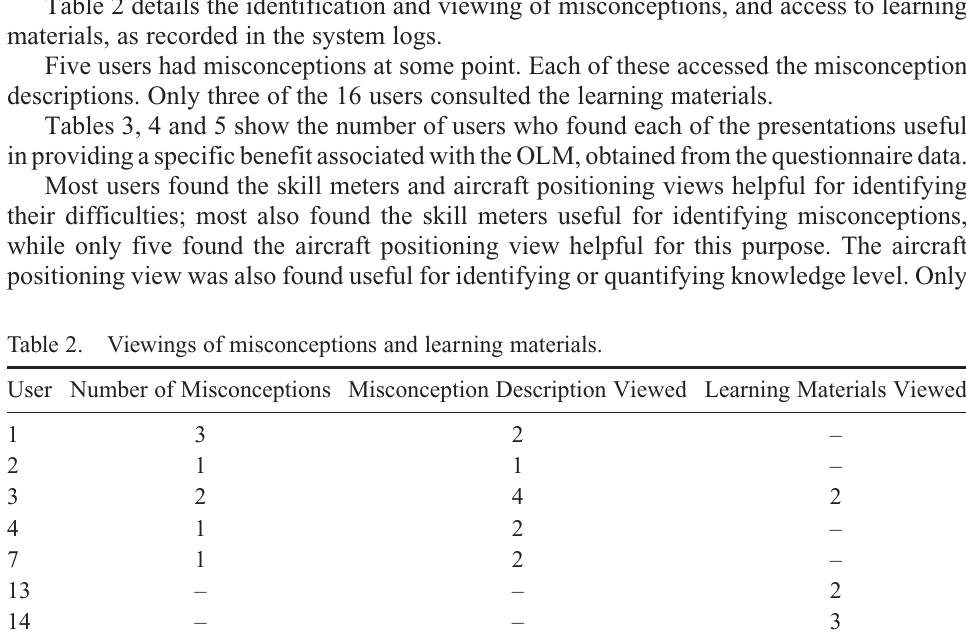
Table 2 details the identification and viewing of misconceptions, and access to learning materials, as recorded in the system logs.